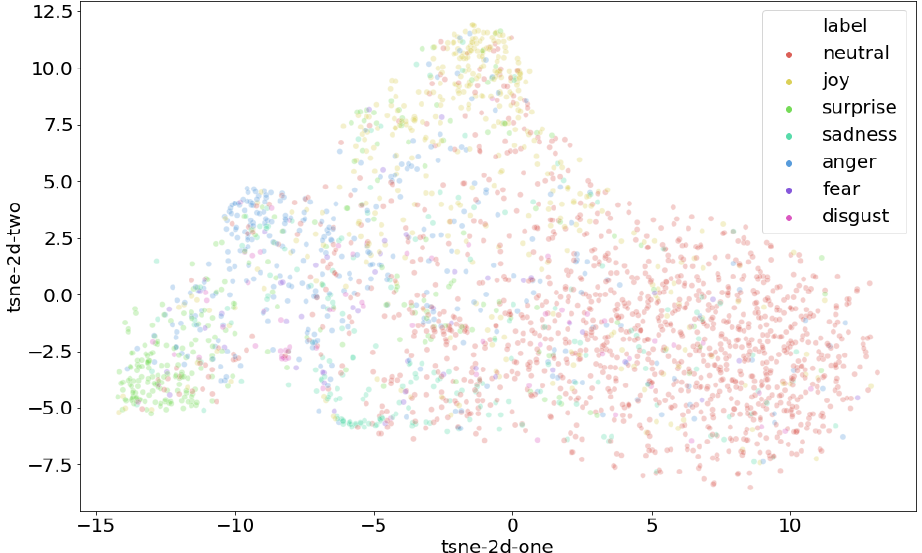
Figure 8. The t-SNE visualization for the